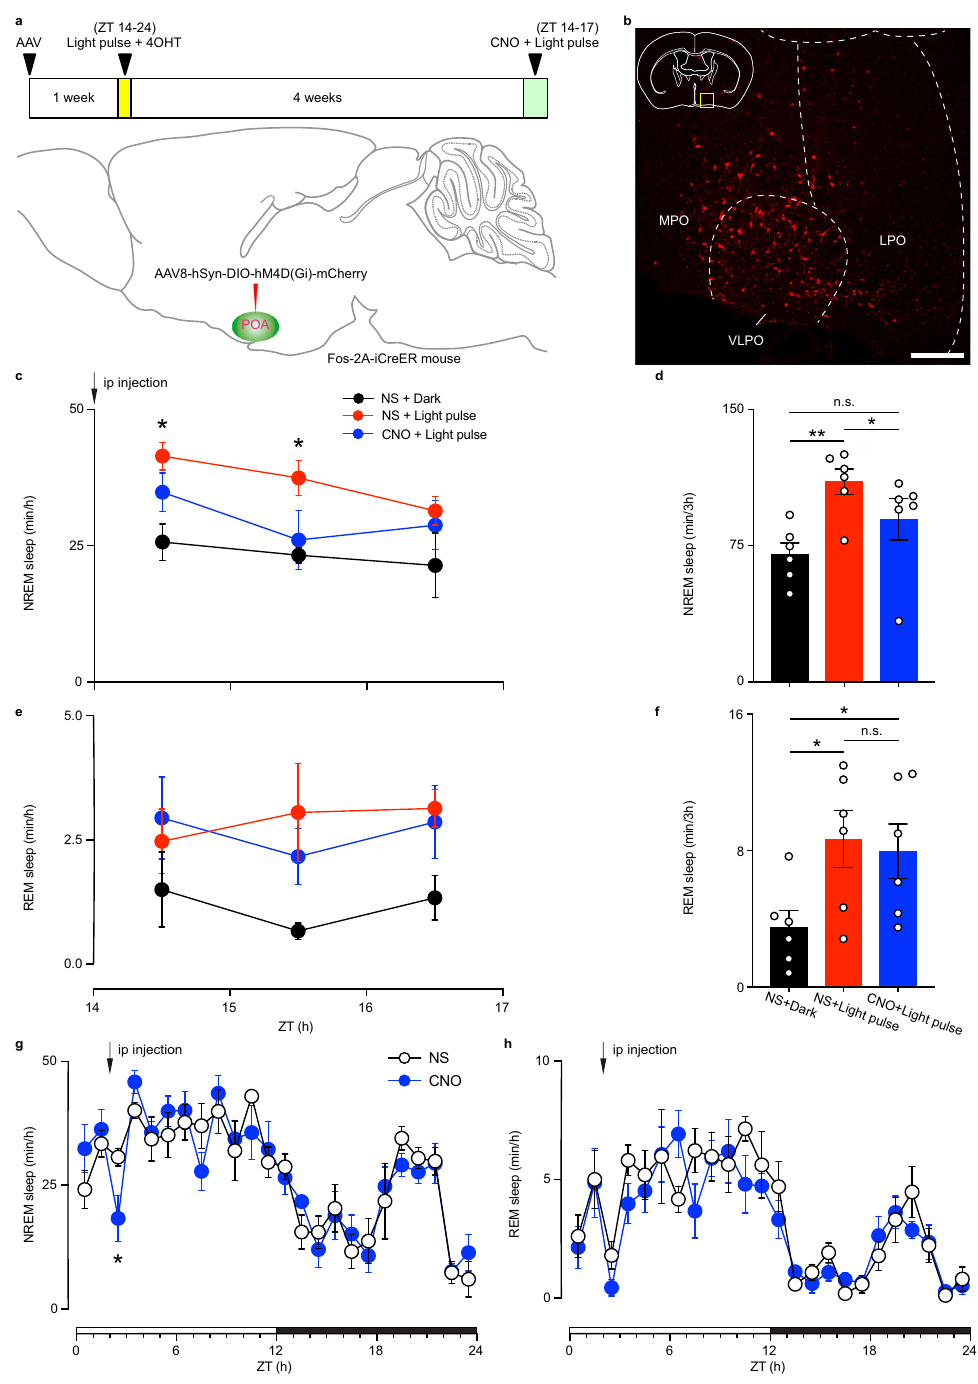
Fig. 3 Inhibition of POA light-responsive neurons abolished light-induced NREM sleep and spontaneous NREM sleep. a Schematic showing virus injection, light exposure, 4-Hydroxytamoxifen (4-OHT) injection, and clozapine-N-oxide (CNO) injection. b Immunostaining of mCherry in the POA ( n = 6 animals; scale bar, 200 μ m). c Time course changes in NREM sleep after normal saline (NS) or CNO injection during light pulse from zeitgeber time (ZT) 14 to ZT 17 ( n = 6 animals; two-way ANOVA, F 2, 15 = 5.453, P = 0.0166, Bonferroni post hoc test. * P < 0.05 indicates signi fi cant difference between NS + Light pulse and NS + Dark). Each cycle represents the hourly mean ± SEM of sleep. d Total time sleep in NREM sleep for 3 h after NS or CNO injection ( n = 6 animals; one-way ANOVA, F 1.351, 6.756 = 18.86, P = 0.0026, Bonferroni post hoc test, * P < 0.05, ** P < 0.01). e Time course changes in REM sleep after NS or CNO injection during light pulse from ZT 14 to ZT 17 ( n = 6 animals; two-way ANOVA, F 2, 15 = 3.735, P = 0.0483). Each cycle represents the hourly mean ± SEM of sleep. f Total time sleep in REM sleep for 3 h after NS or CNO injection ( n = 6 animals; one-way ANOVA, F 1.194, 5.970 = 7.292, P = 0.0328, Bonferroni post hoc test, * P < 0.05). g Time course changes in NREM sleep after NS or CNO injection ( n = 6 animals; two-way ANOVA (ZT 14 to ZT 16), F 1, 10 = 6.560, P = 0.0283, Bonferroni post hoc test, * P < 0.05). Each cycle represents the hourly mean ± SEM of sleep. The white and black bars on the x axes indicate light-on and light-off periods, respectively. h Time course changes in REM sleep after NS or CNO injection ( n = 6 animals; two-way ANOVA, F 1, 10 = 0.9305, P = 0.5375). All error bars denote SEM. MPO, medial preoptic area; LPO, lateral preoptic area; VLPO, ventrolateral preoptic nucleus; n.s., non-signi fi cant; NREM, non-rapid eye